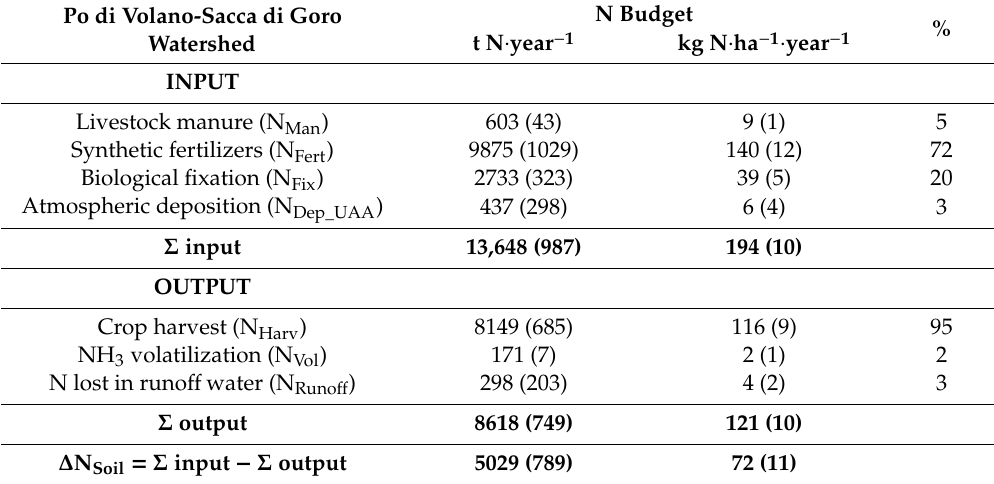
Table 2. Nitrogen budget in the agricultural soils of the Po di Volano-Sacca di Goro watershed (average of the five-year period 2006–2010; standard deviation is reported in brackets). Budget items are expressed as tons of N imported or exported per year (t N · year − 1 ) in the whole area and normalized for the utilized agricultural area (kg N · ha − 1 · year − 1 ). The percentage of each input or output with respect to the total is also